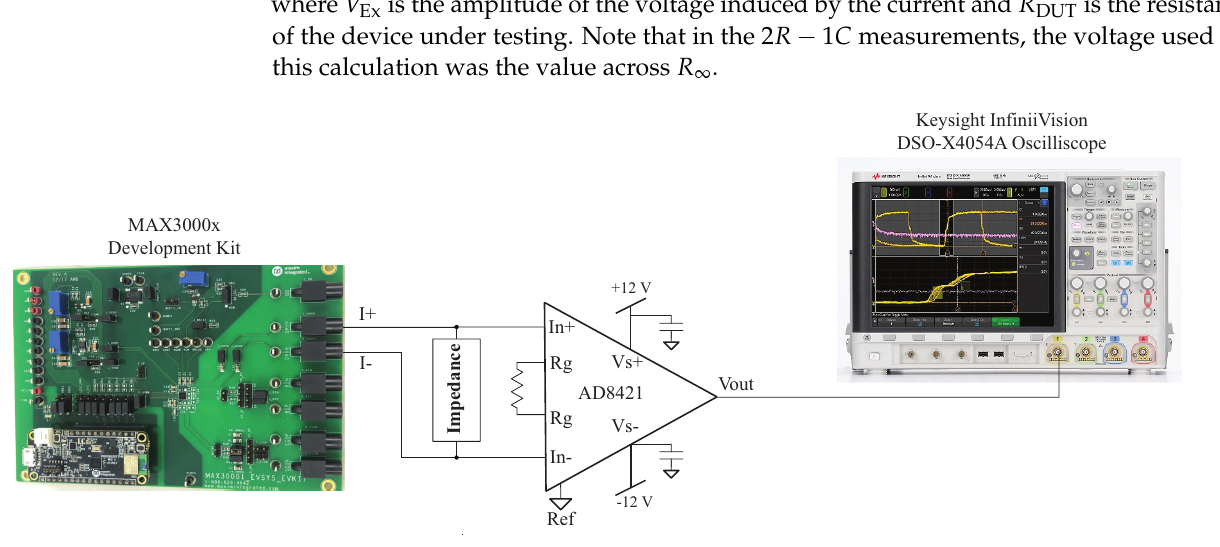
Figure 10. Experimental setup for measuring the excitation current applied by the MAX3000x development kit to a test impedance.